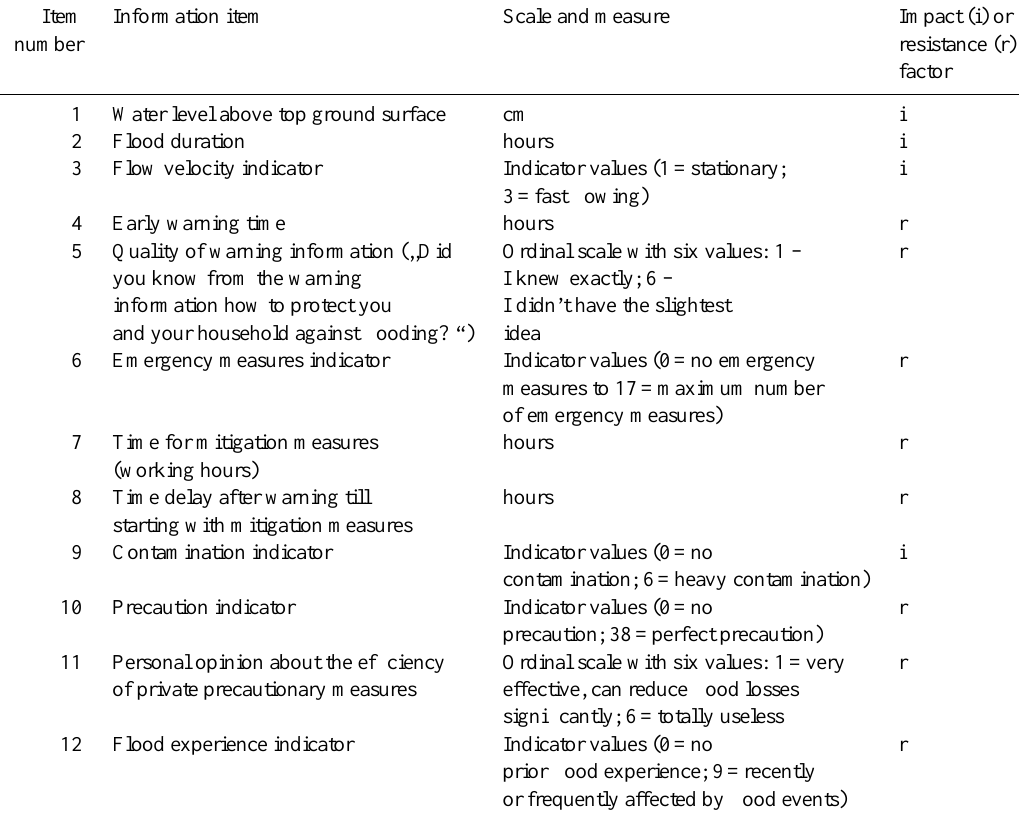
Table 2. Selected items for principal component